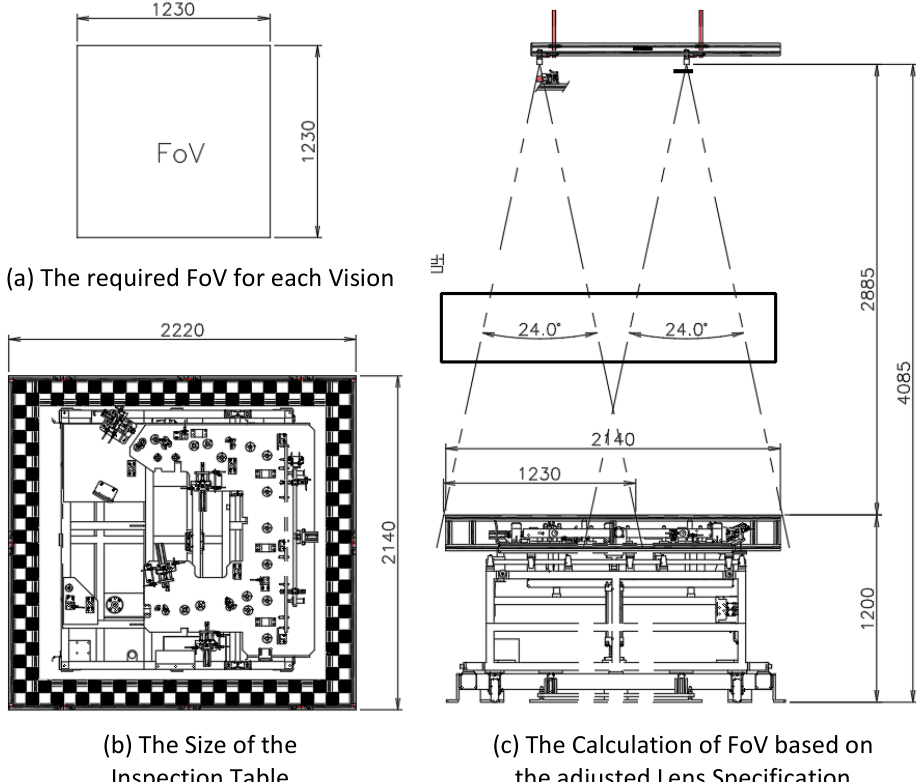
Figure 8. Calculation of FoV with the adjusted lens specification.